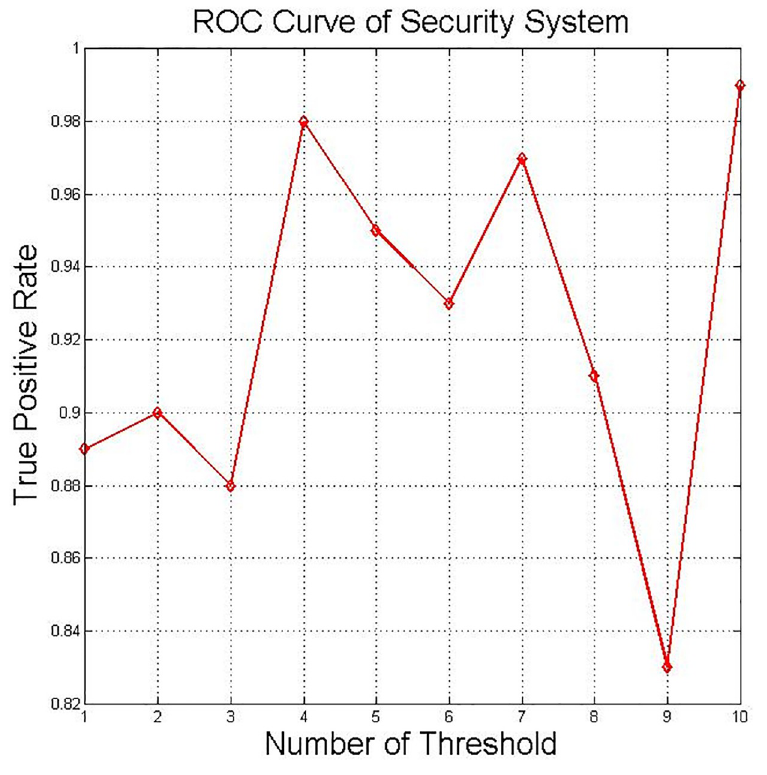
Fig 12. ROC curve for DNN—TPR.